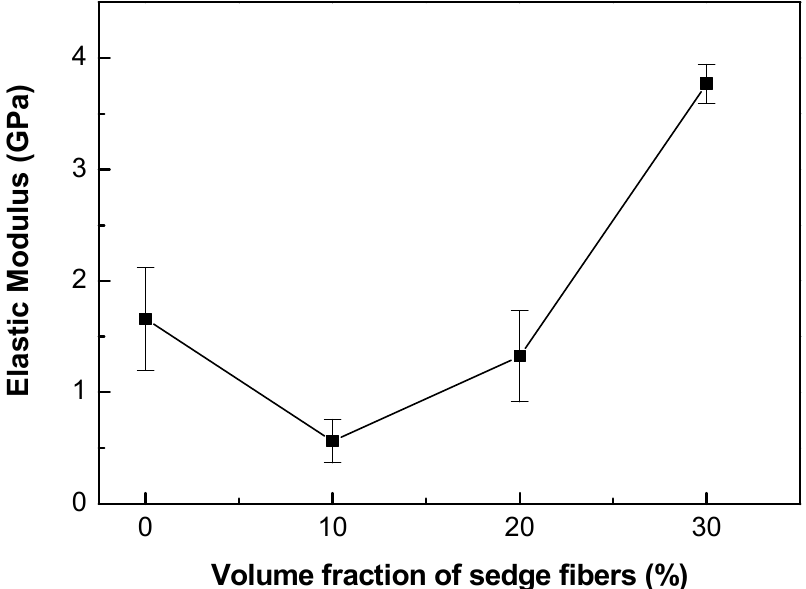
Figure 8. Elastic modulus as a function of the fiber fraction for the neat epoxy resin and CM sedge fiber-reinforced composites.